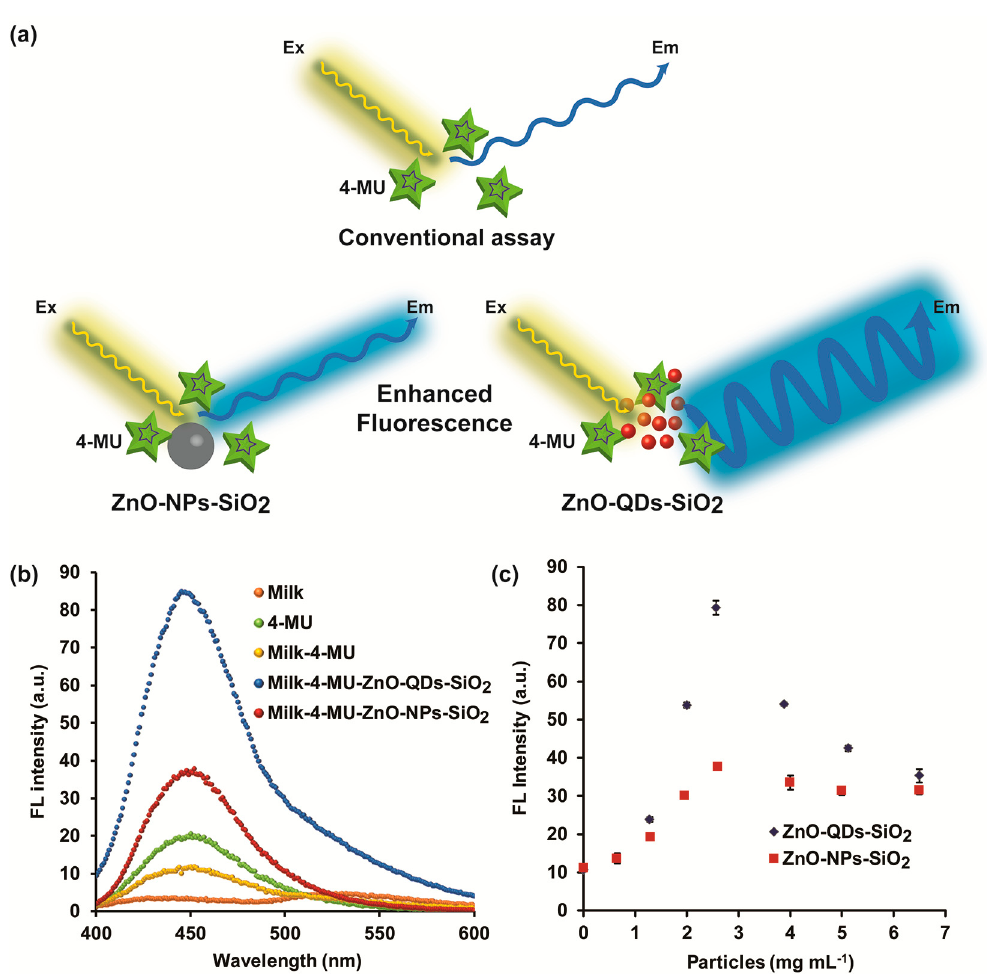
Figure 2. ( a ) Schematic illustration of FL signal amplification by ZnO nanomaterials; ( b ) FL emission spectra of NAGase biochemical reaction products (4-MU fixed at 20 µM) with and without ZnO-QDs-SiO 2 and ZnO-NPs-SiO 2 ; ( c ) Silica-coated ZnO nanomaterials’ content optimization of NAGase activity assay within mastitic milk. Data are reported as mean ± S.D. (n ≥ 3).